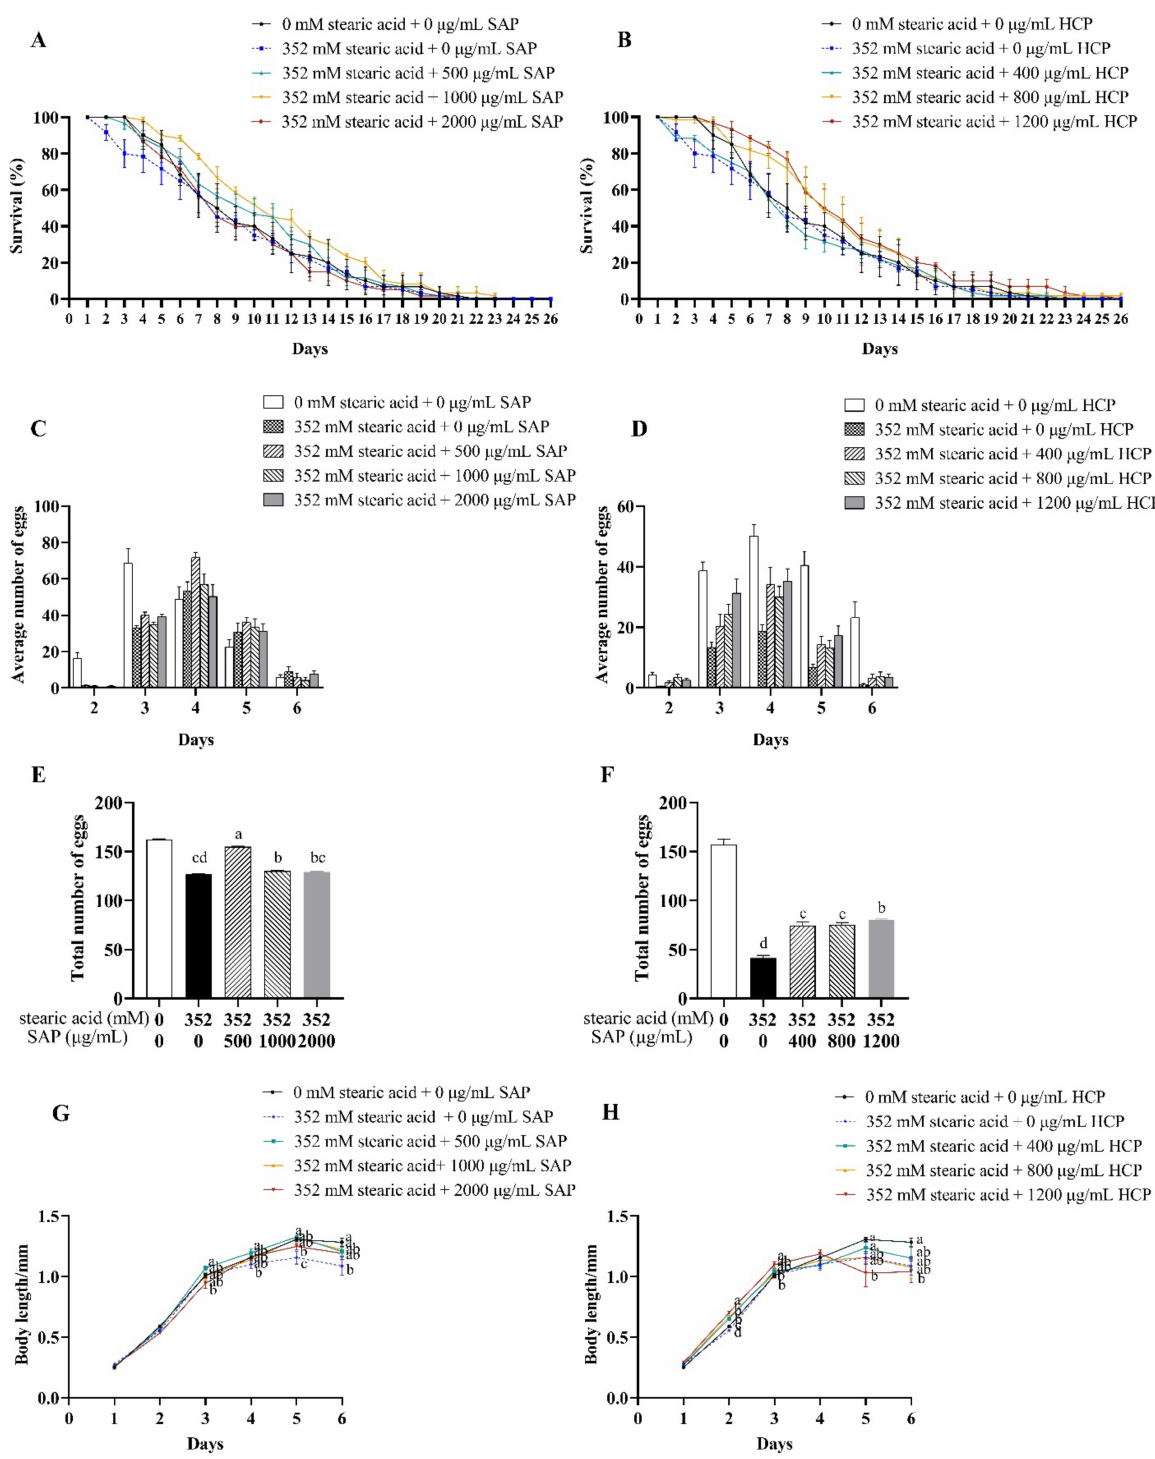
Figure 5. Effects of SAP and HCP on life-span, reproduction, and body length of the stearic acid- incubated C. elegans . ( A , B ): effects of SAP ( A ) and HCP ( B ) on the lifespan of stearic acid-incubated C. elegans . ( C , D ): effects of SAP ( C ) and HCP ( D ) on the average number of eggs of stearic acid- incubated C. elegans on each day. ( E , F ): effects of SAP ( E ) and HCP ( F ) on the total number of eggs of stearic acid-incubated C. elegans in the entire spawning period. ( G , H ): effects of SAP ( G ) and HCP ( H ) on the body length of stearic acid-incubated C. elegans . Data are presented as mean ± SEM (n = 30). Values without a common letter are significantly different at p <